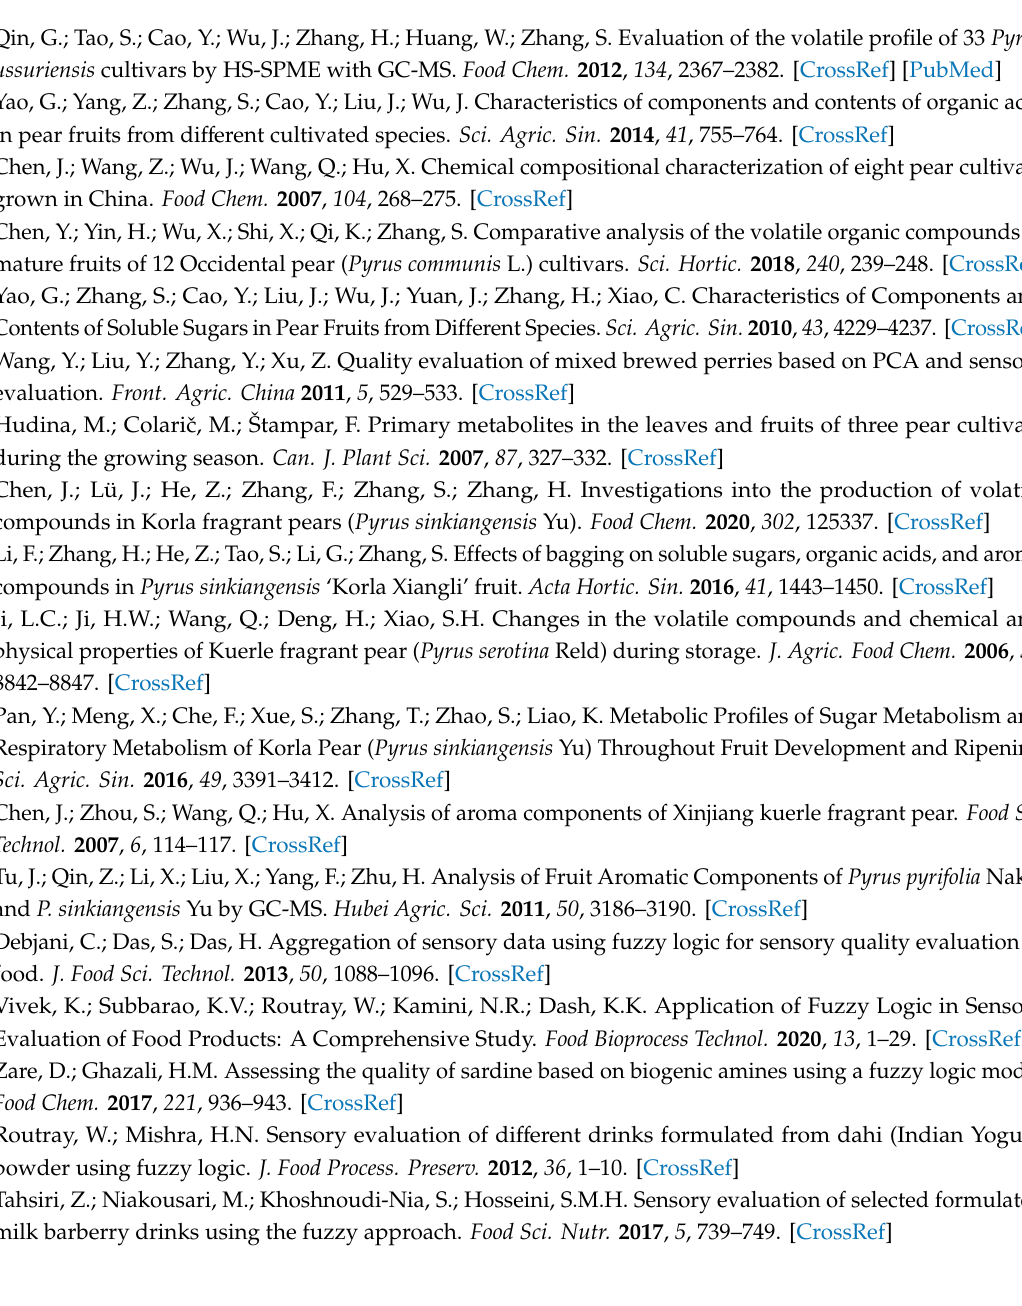
Supplementary Materials: The following are available online. Table S1: Sensory scores for pear samples and the corresponding triplets; Table S2: Preferences given by panelists and corresponding triplets for relative weightage; Table S3: Overall triplets of pear samples; Table S4: Values of overall membership function of pear samples; Table S5: Similarity values of quality attributes for Korla pear; Table S6: Primary metabolites detected in the pulp of Korla pear by using GC-MS; Table S7: Volatiles detected in the peel of Korla pear by using HS-SPME-GC-MS; Table S8: Seven volatile compounds uniquely detected in specific orchards in 2018; Table S9: List of potential chemical